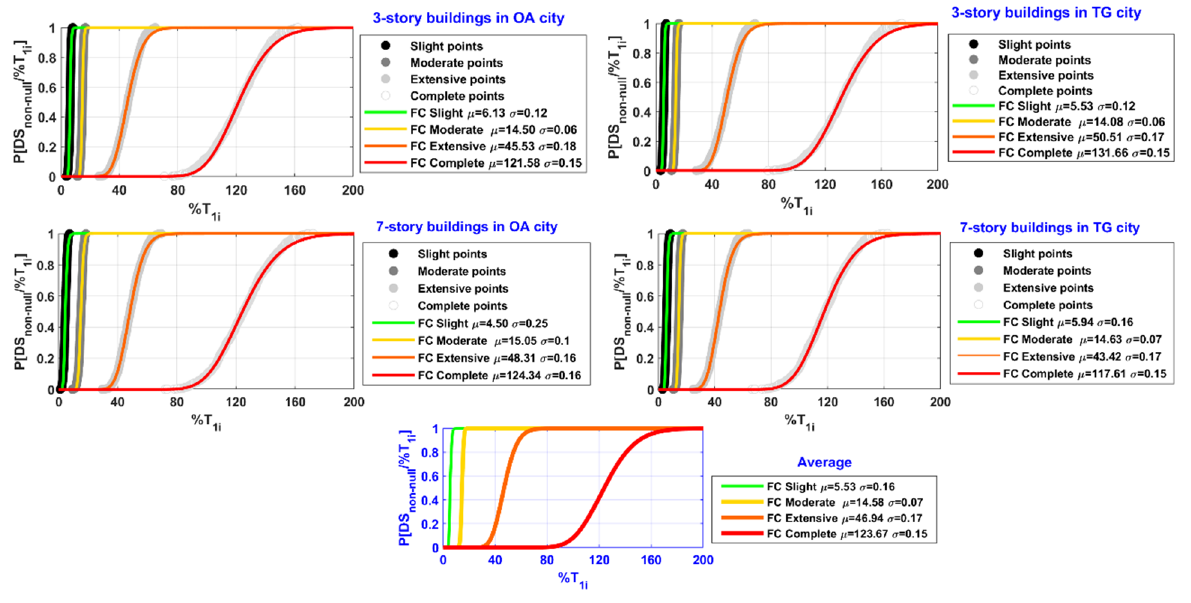
Figure 10. Probabilistic fragility curves of the DS non-null for the buildings in OA and TG cities as functions of the %T 1i .